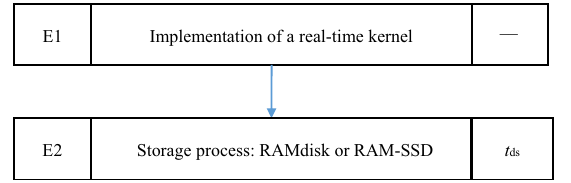
Fig. 8 Stages to prepare a real-time environment for MBS simula- tion. In each stage, the columns from first to third represent name, task, and associated time of that stage,